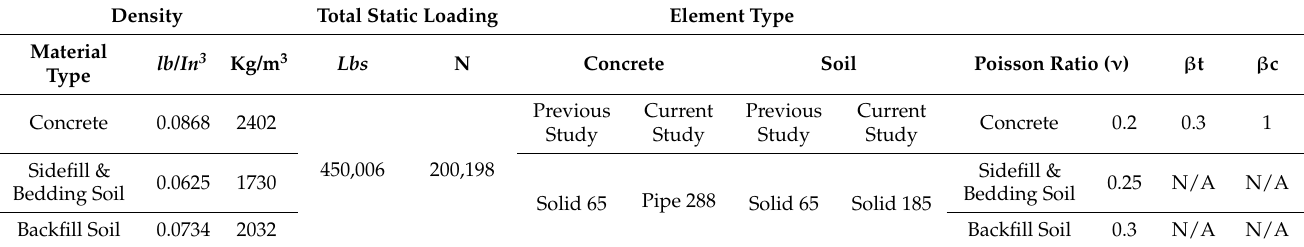
Table 5. Material properties of soil and concrete for validation in FE.